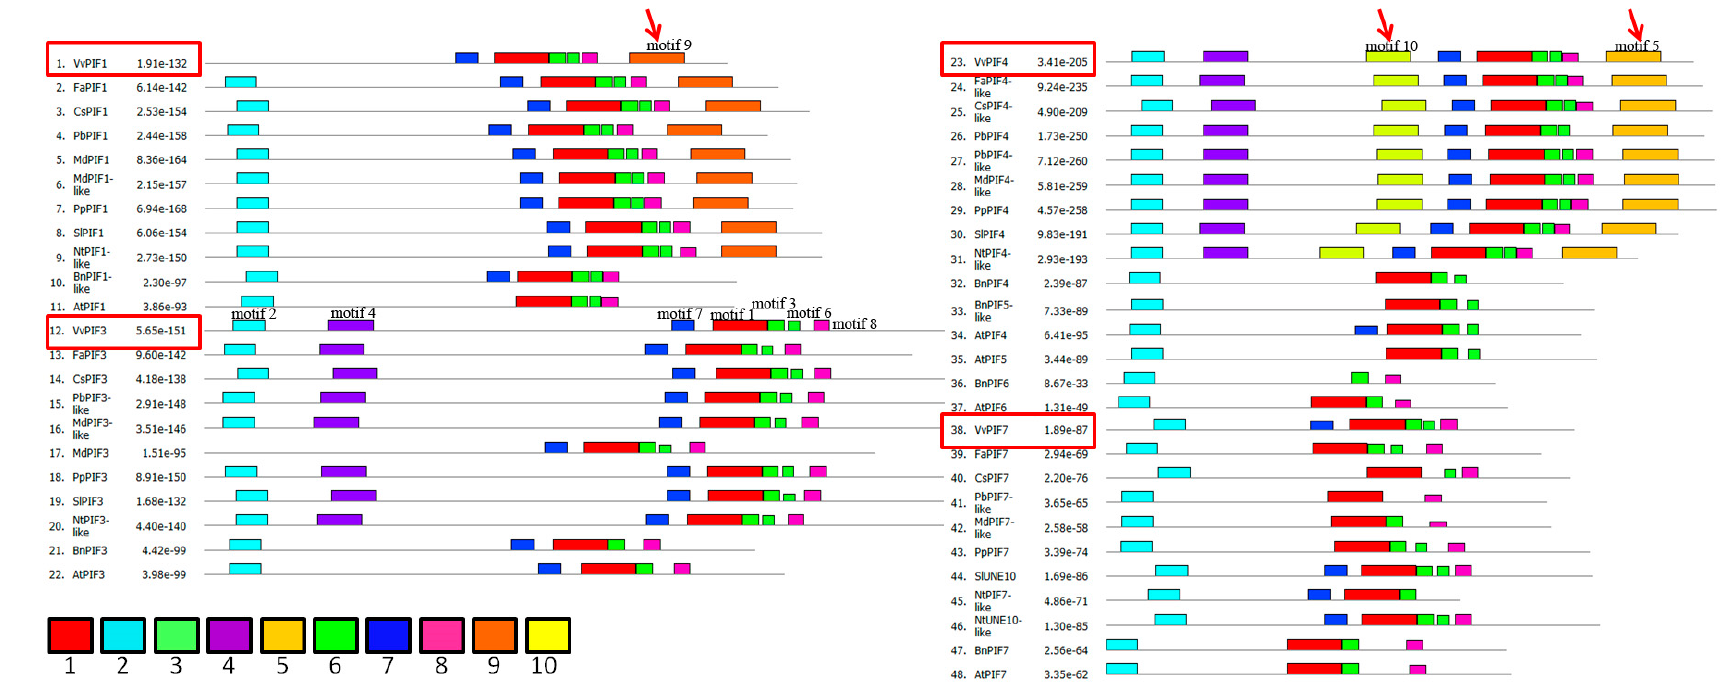
Figure 4. MEME analysis of the conserved motifs of PIFs protein. The motif number was set as 10 and one color corresponds to one motif. The amino acid sequence corresponding to each motif was present in Figure S1. The arrows indicate the specific motifs for PIF1 and PIF4 compared to other PIFs. The motif name of each color was labeled in VvPIF1, VvPIF3 and VvPIF4, respectively.